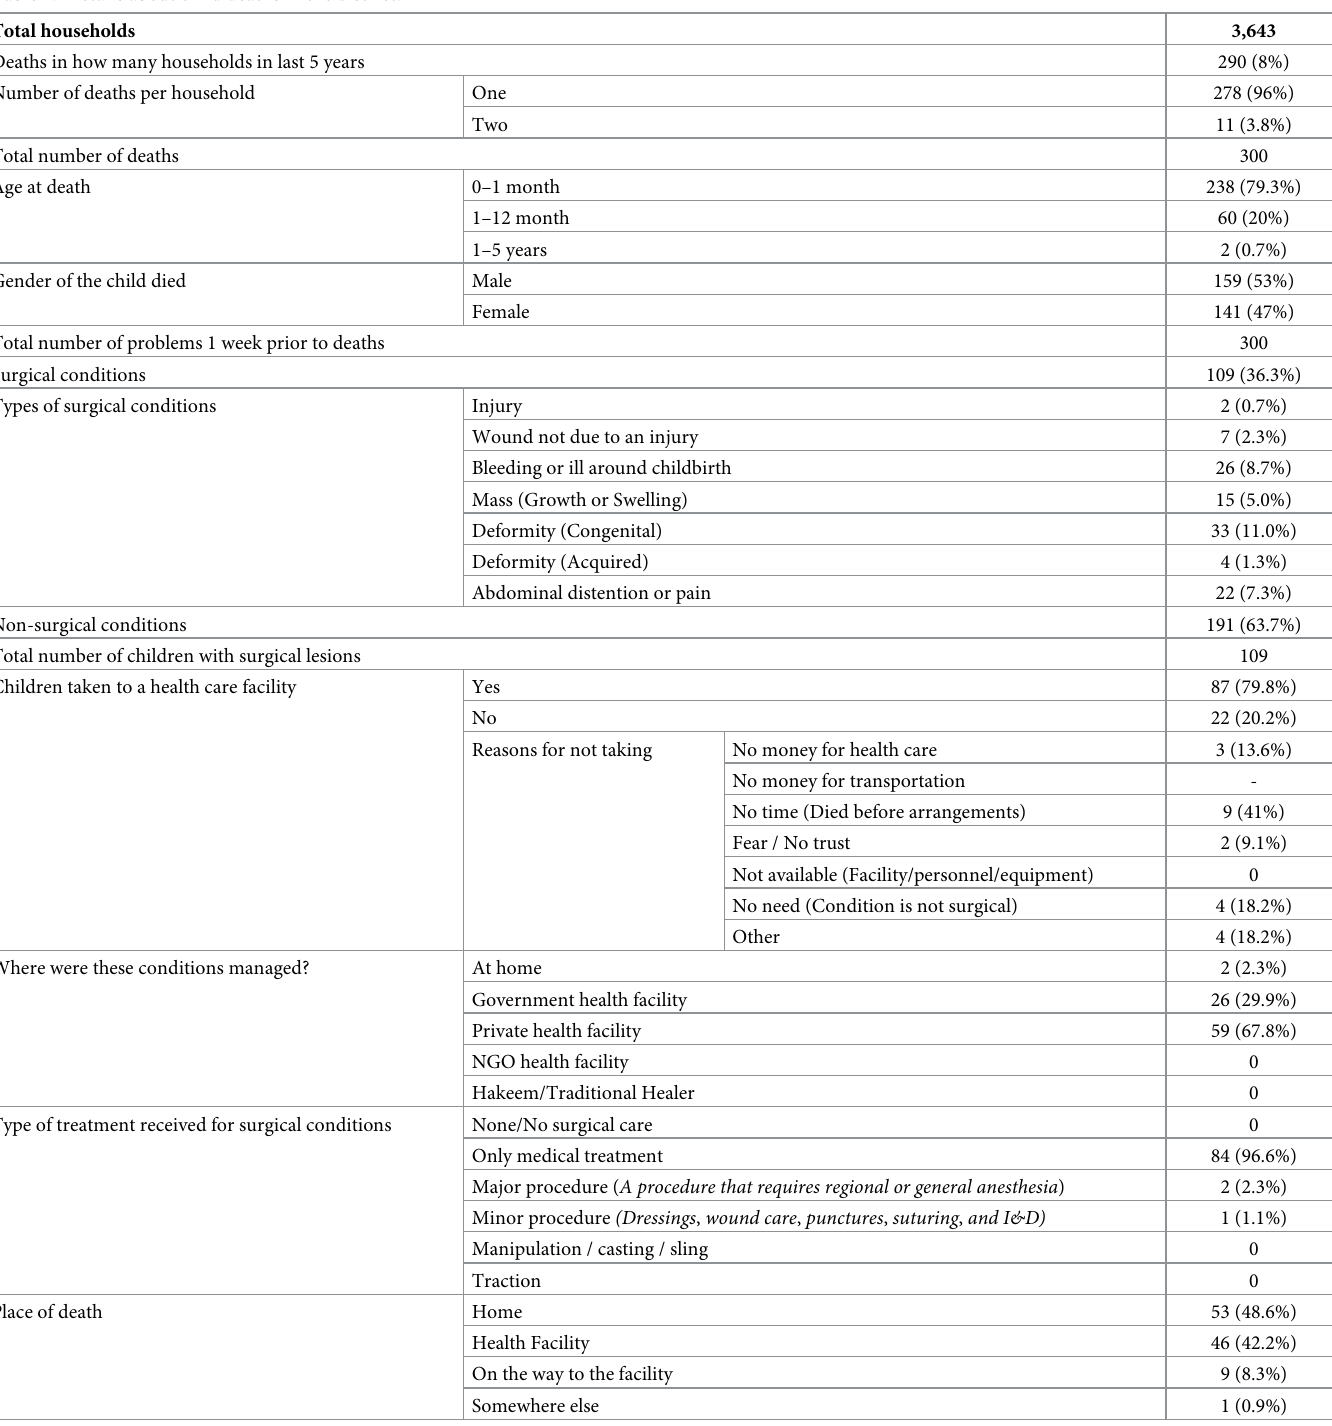
Table 1. Details about child deaths in the